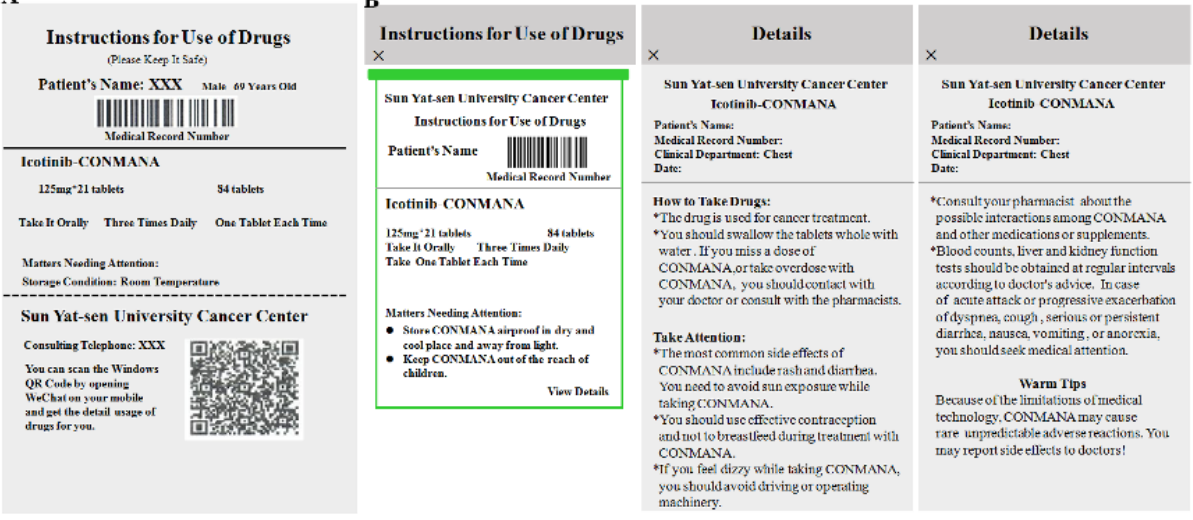
Figure 3. Screenshots of drug instructions shared with patients ordering drugs via the Cloud SYSUCC app: (A) printed version and (B) electronic